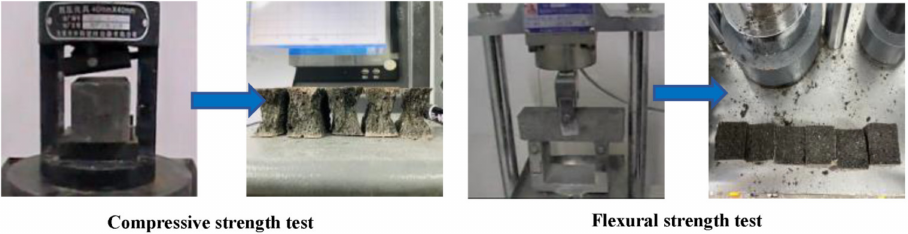
Figure 5. Pictures of the compressive strength and flexural strength tests.